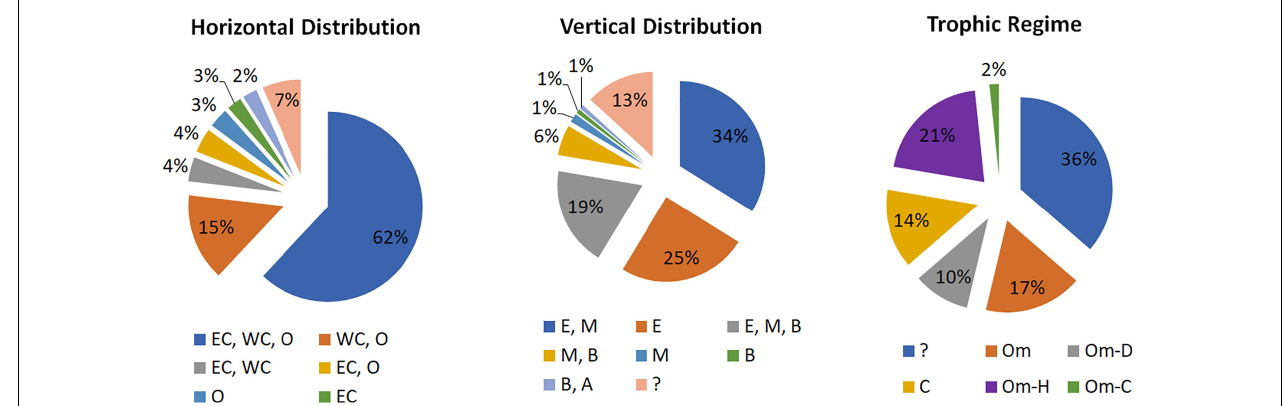
FIGURE 5 | Pie charts showing the horizontal and vertical distribution of pelagic copepods in the South Pacific Ocean (EC = East Coast, WC = West Coast, O = Oceanic; E = Epipelagic, M = Mesopelagic, B = Bathypelagic, A = Abisopelagic) and trophic regime (Om = Omnivore, D = Detritivore, H = Herbivore, C = Carnivore (Razouls et al., 2005/2019; Benedetti et al., 2016).